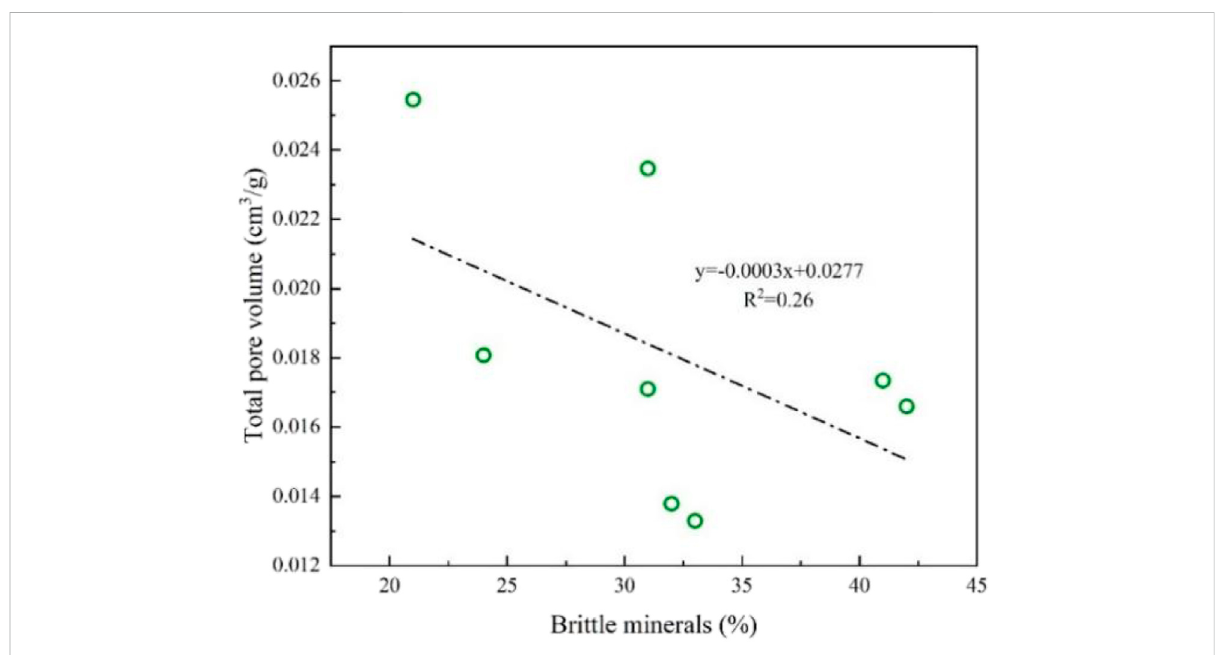
FIGURE 11 Correlation between brittle minerals and total pore volume in shale. Notes: Brittle minerals include quartz, feldspar, calcite, pyrite, and siderite.